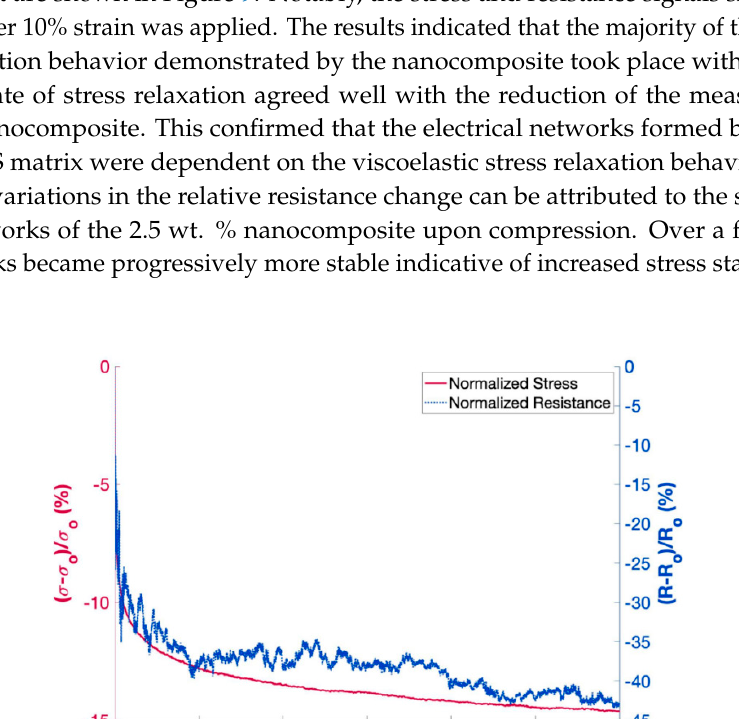
Figure 10. Sensing application of 2.5 wt. % porous nanocomposite: ( a ) experimental setup and sensing functions during various squeezing rates including: ( b ) slow, ( c ) medium, ( d ) fast, and ( e ) 5 s pauses at maximum and minimum compression. 4. Conclusions